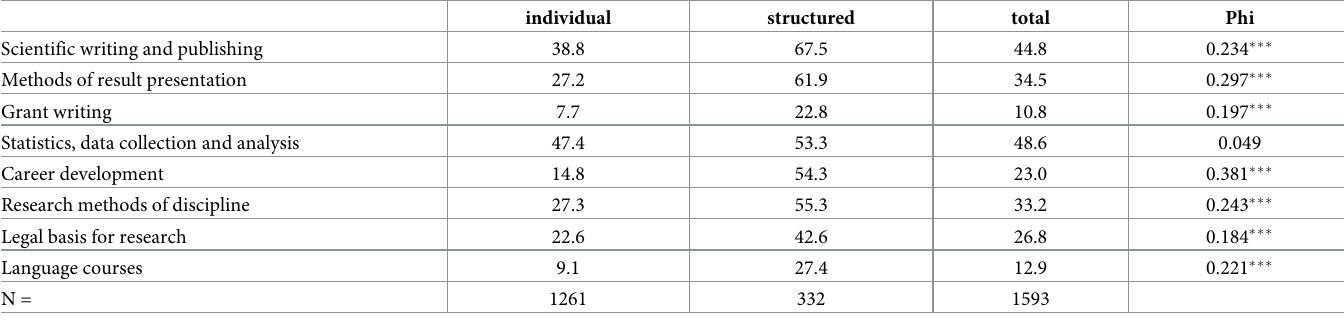
Table 8. Formal learning—non-regular learning